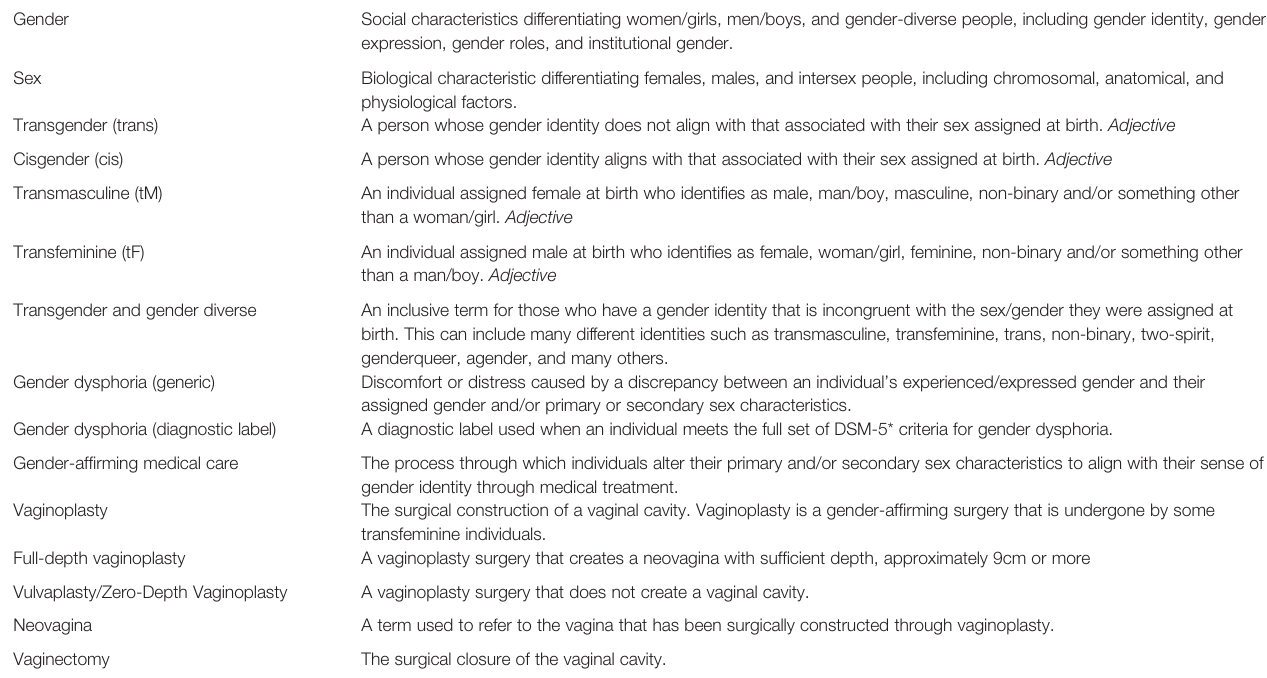
TABLE 1 | Key terminology.